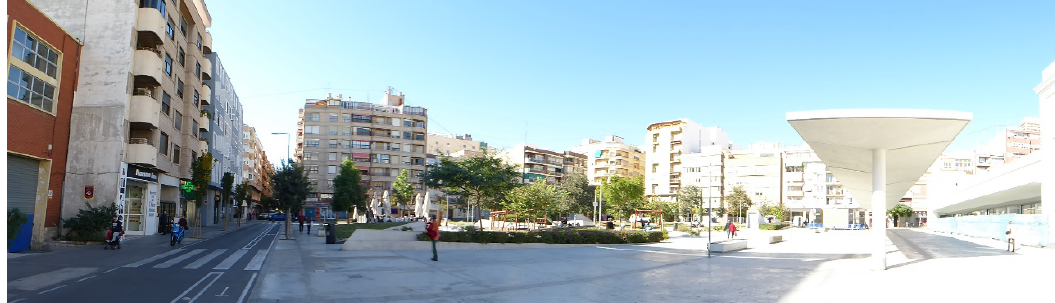
Figure 3. Current view of Seneca Square.